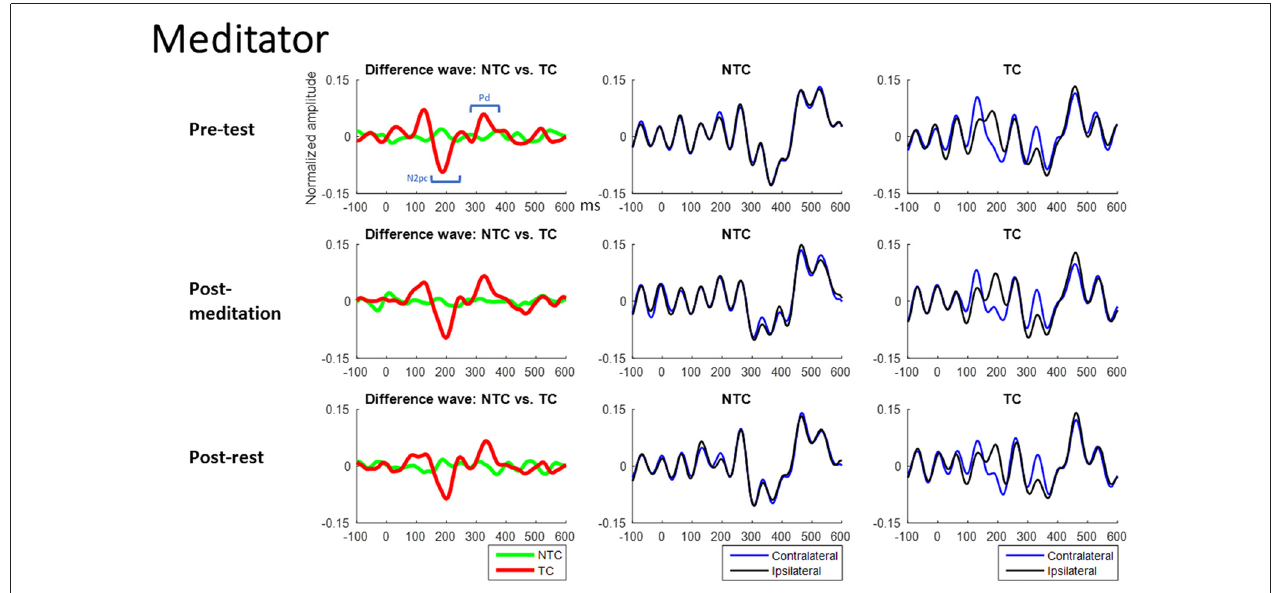
FIGURE 7 | Meditator group’s ERM waveforms from the RSVP task. The Waveforms of left Column were derived from the differences between contralateral and ipsilateral waveforms. The middle Column is the contralateral and ipsilateral waveforms of NTC condition. The right Column is the contralateral and ipsilateral waveforms of TC condition. The X -axis is time (ms), and 0 ms is distractor onset. The Y-axis is normalized amplitude. EEG data of all trials in each channel were normalized by dividing it into its standard deviation, therefore resulting in a unit-free measure of the amplitude.